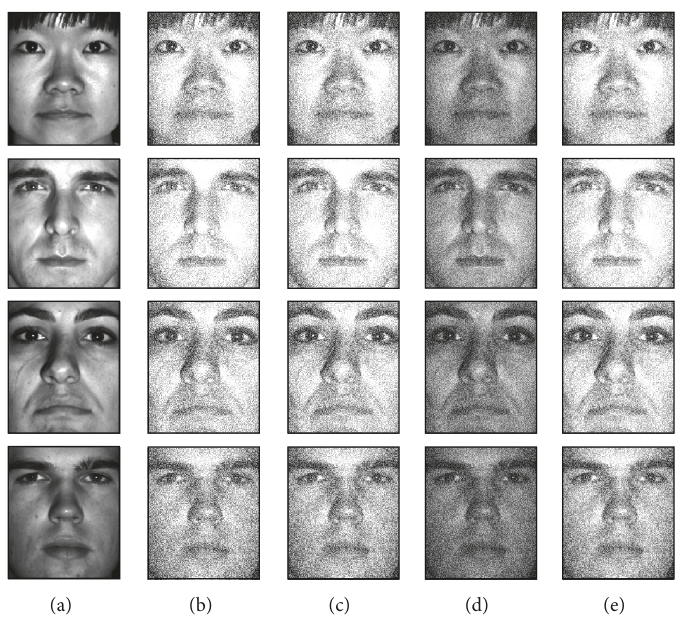
Figure 12: Face image denoising. (a) Original face images. (b) Noisy images. (c) Denoised faces using COAOL. (d) Denoised faces using our proposed algorithm. (e) Denoised faces using